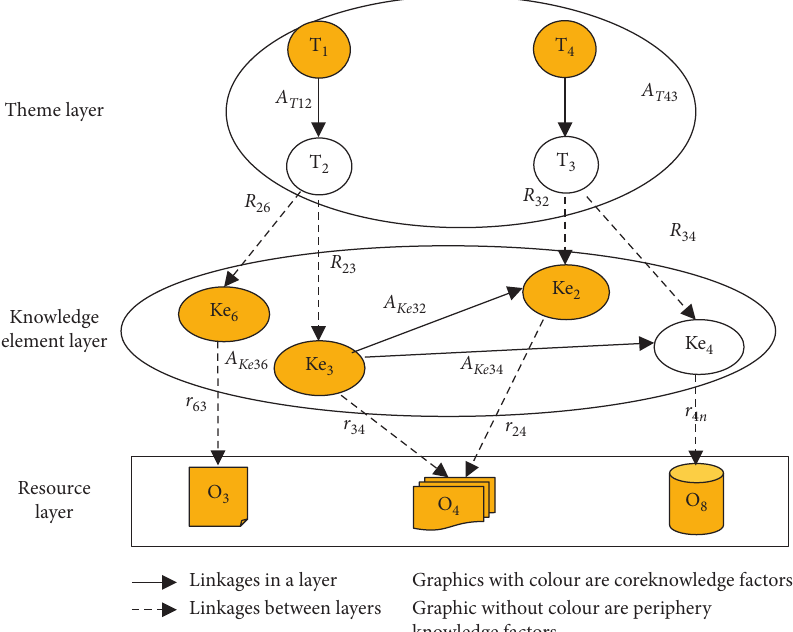
Figure 4: Reconstruct knowledge map of latecomers.